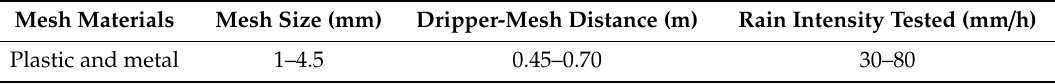
Table 1. Typologies and ranges considered during rainfall simulator calibration.